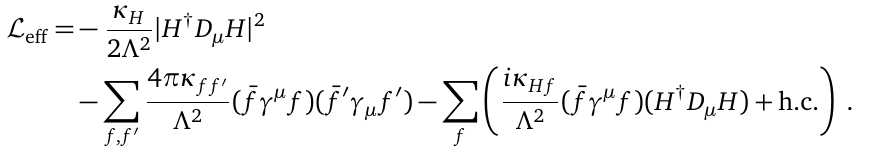
, the mass m , and the gauge cou- Z (cid:48) Z (cid:48) gauge boson with L µ − L τ = 0 (lower Z (cid:48)